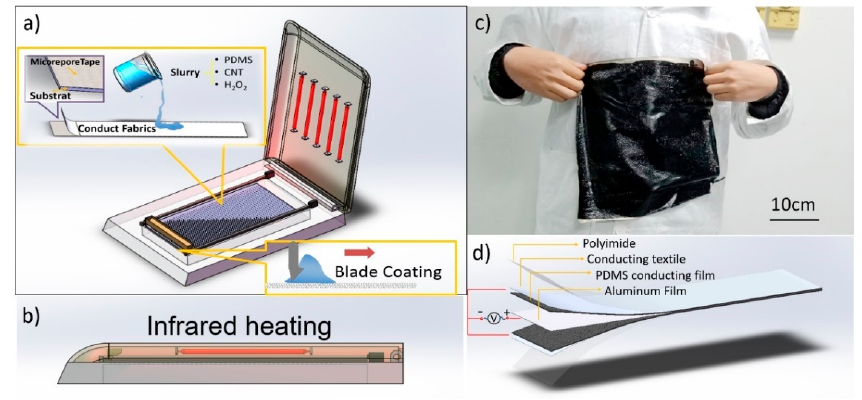
Figure 1. ( a ) Porous film fabrication process; ( b ) infrared heating chamber; ( c ) large-scale sample; ( d ) triboelectric nanogenerator (TENG) structure. ( d ) triboelectric nanogenerator (TENG)